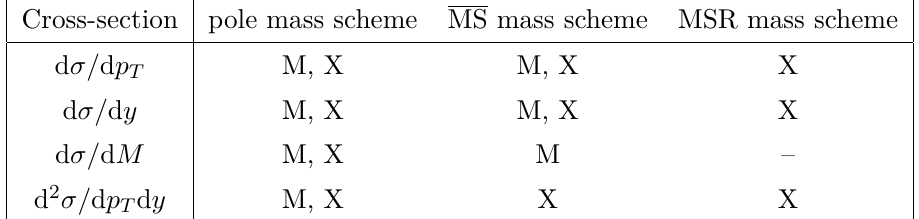
Table 2 . Summary of the capabilities of the MCFM (M) and xFitter (X) frameworks to compute differential cross-sections for heavy-quark hadro-production in different mass